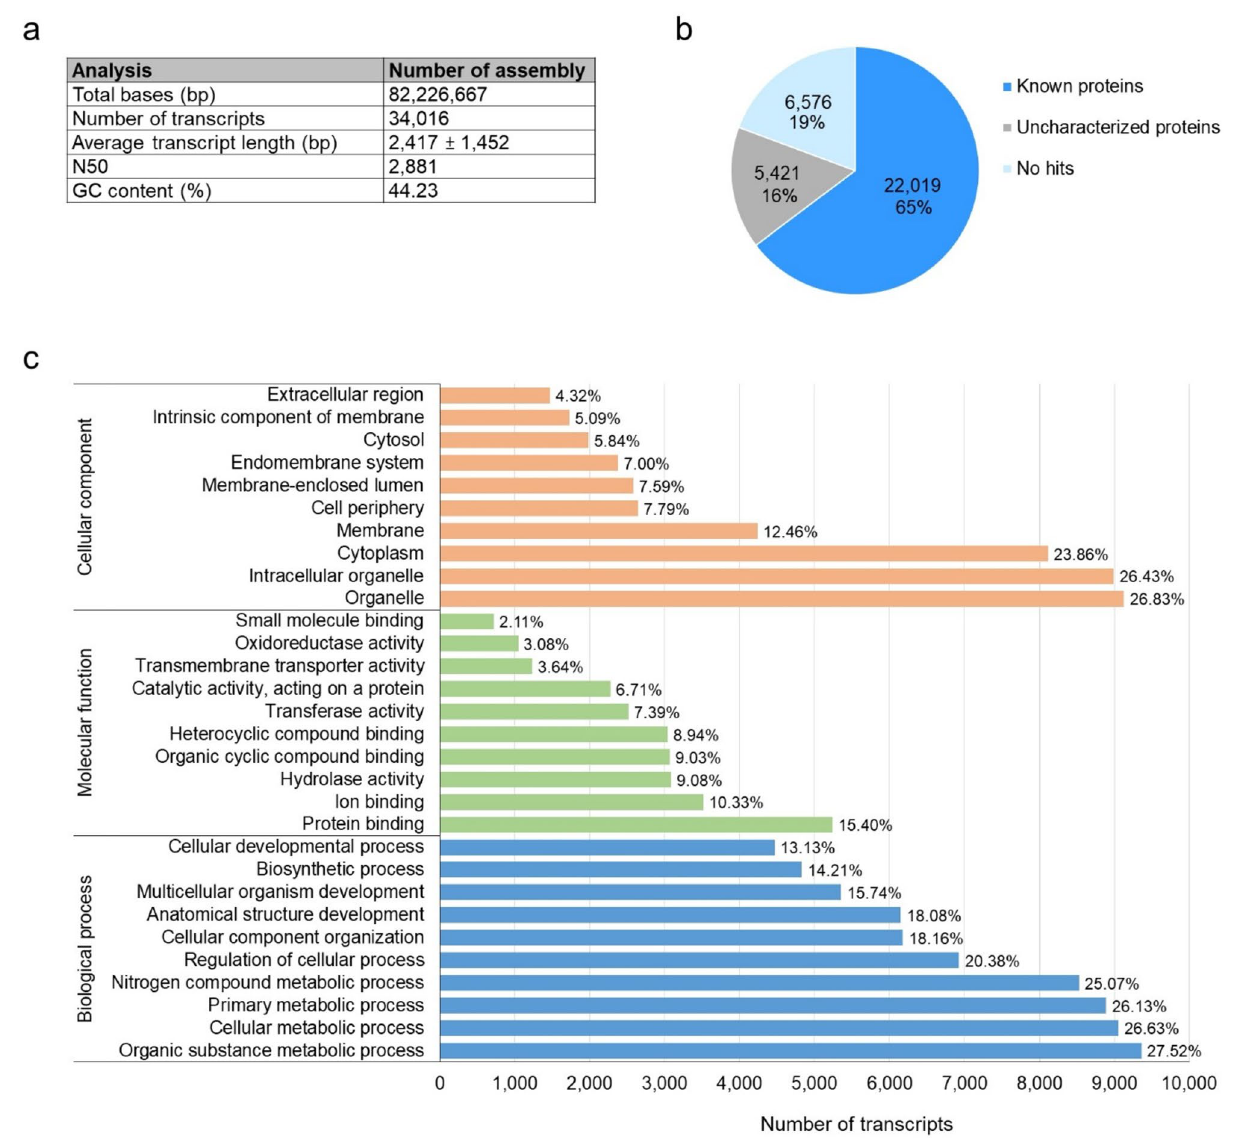
Figure 2. Summary of assembly and annotation of P. monodon at early developmental stages, including nauplius, zoea, mysis and 15-day-old postlarva. ( a ) Summary of read depth of RNAseq data. ( b ) The pie chart shows percentage of transcripts matched sequences in NCBI RefSeq database. ( c ) Histogram gene ontology classification of the transcripts into three main categories including biological process, molecular function and cellular